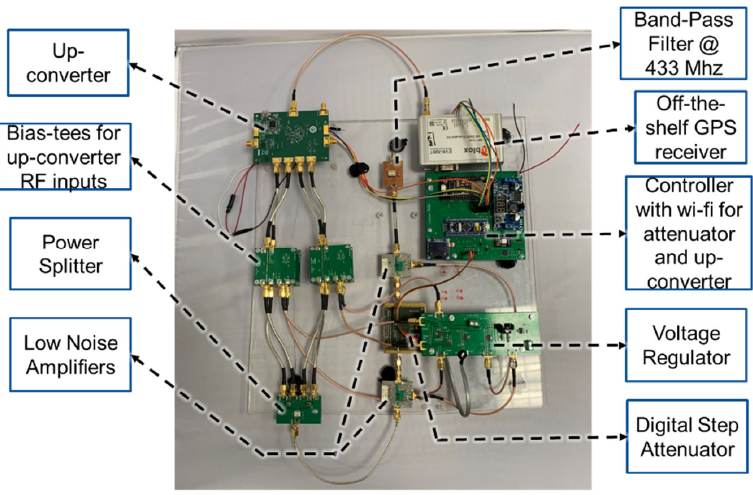
Figure 6. Implemented up-converting receiver excluding the antenna.